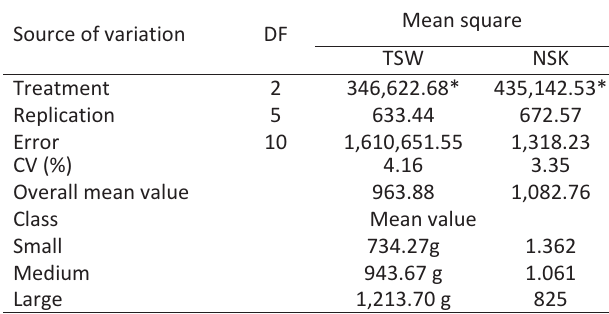
significant at 5% probability by F-test.